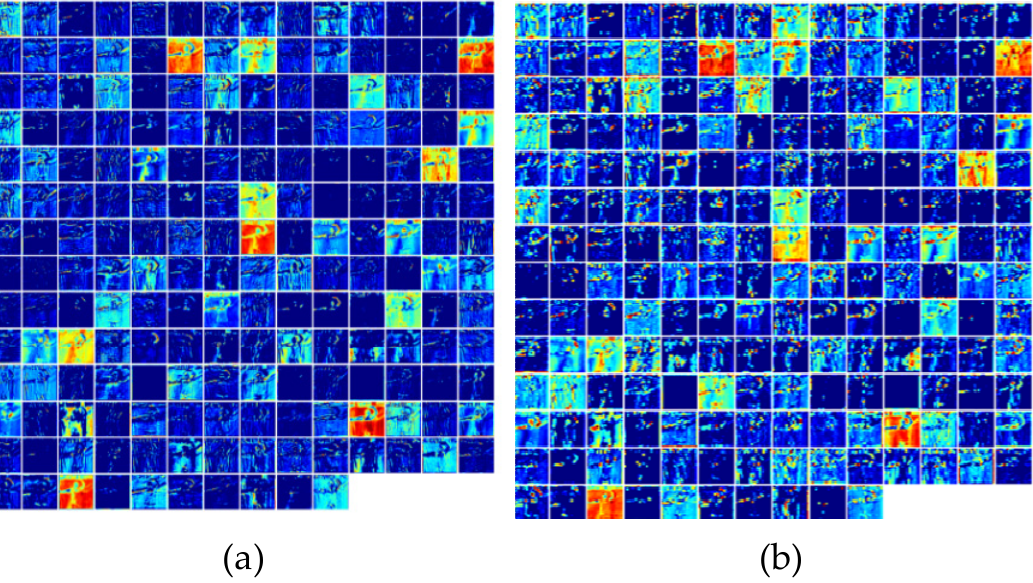
Figure 6. Comparison of channel feature map between I3D and MSA-3D: ( a ) features of each channel extracted after the third layer of I3D network; ( b ) features of each channel extracted after the third layer of MSA-3D network.